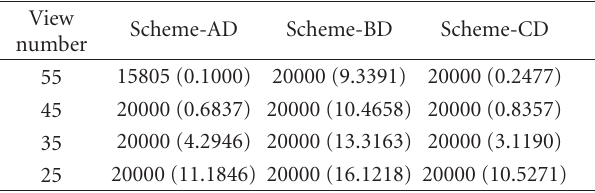
Table 2: Same as Table 1 but for the direct implementation counterparts of the proposed